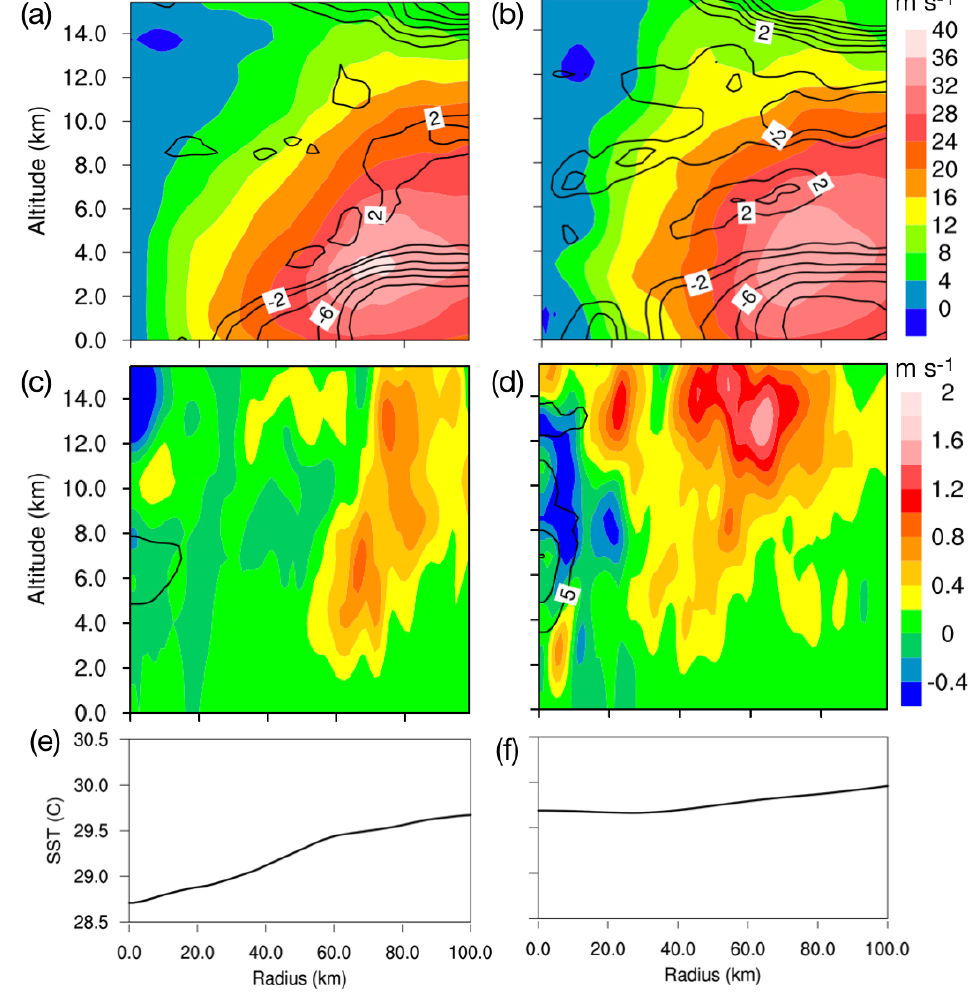
Figure 7. The radial distribution of the azimuthally averaged fields at 1400 UTC 22 August. Panel ( a ) is tangential (shaded, m s − 1 ) and radial wind (contours, m s − 1 , positive values indicate the inflow) in CPL experiment. ( c ) updrafts (shaded, m s − 1 ) and the potential temperature anomalies (contours with the interval of 5 ◦ C, measured with respect to the mean potential temperature within a radius of 300 km) in CPL storm. Panel ( e ) is SST ( ◦ C) under the CPL storm. Panels ( b , d , f ) are same with (a, c ,e) but in the FO experiment,